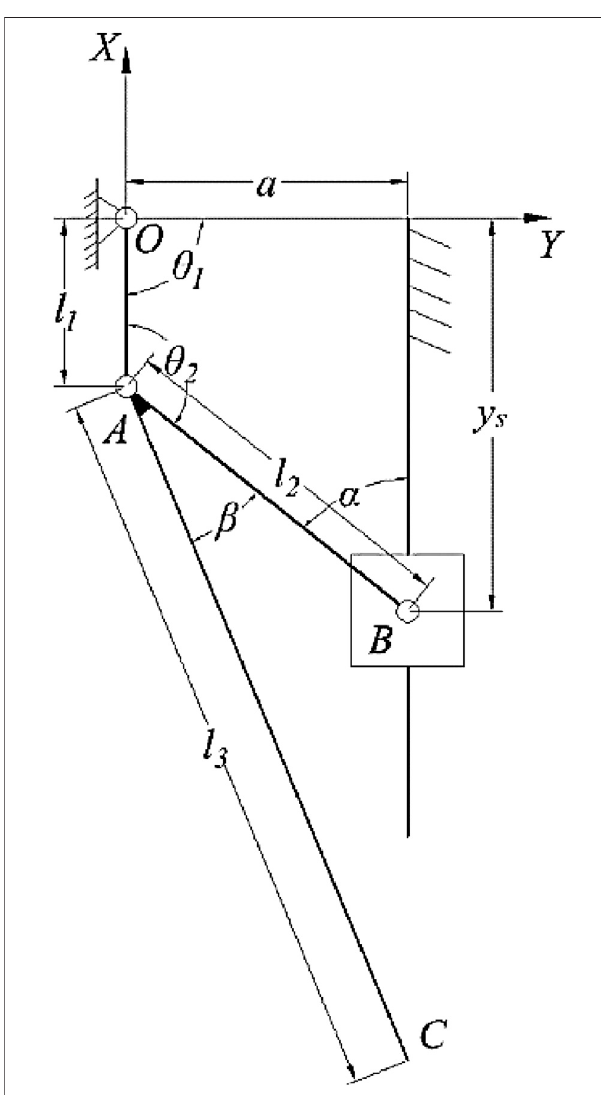
FIGURE 2 | The adjustable slider-crank